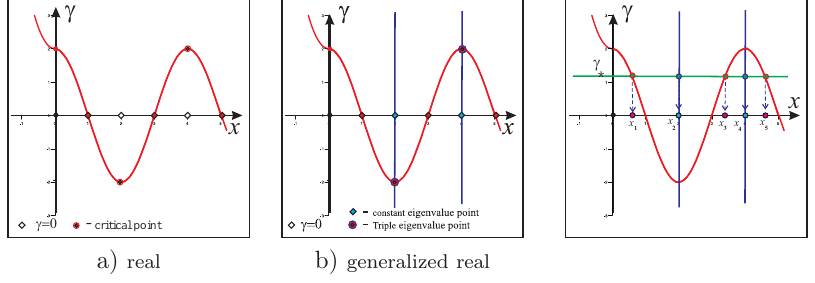
Figure 11. Generalized real characteristic function and real eigenvalue points x i .